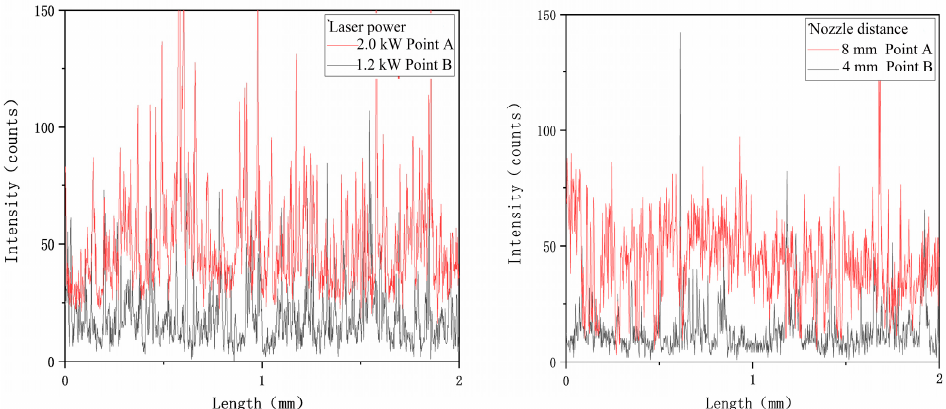
Figure 4. Surface oxygen content analyzed by electron probe micro-analyzer (EPMA) line scanning of ( a ) Point A and B in Figure 2a; ( b ) Point A and B in Figure 2c.